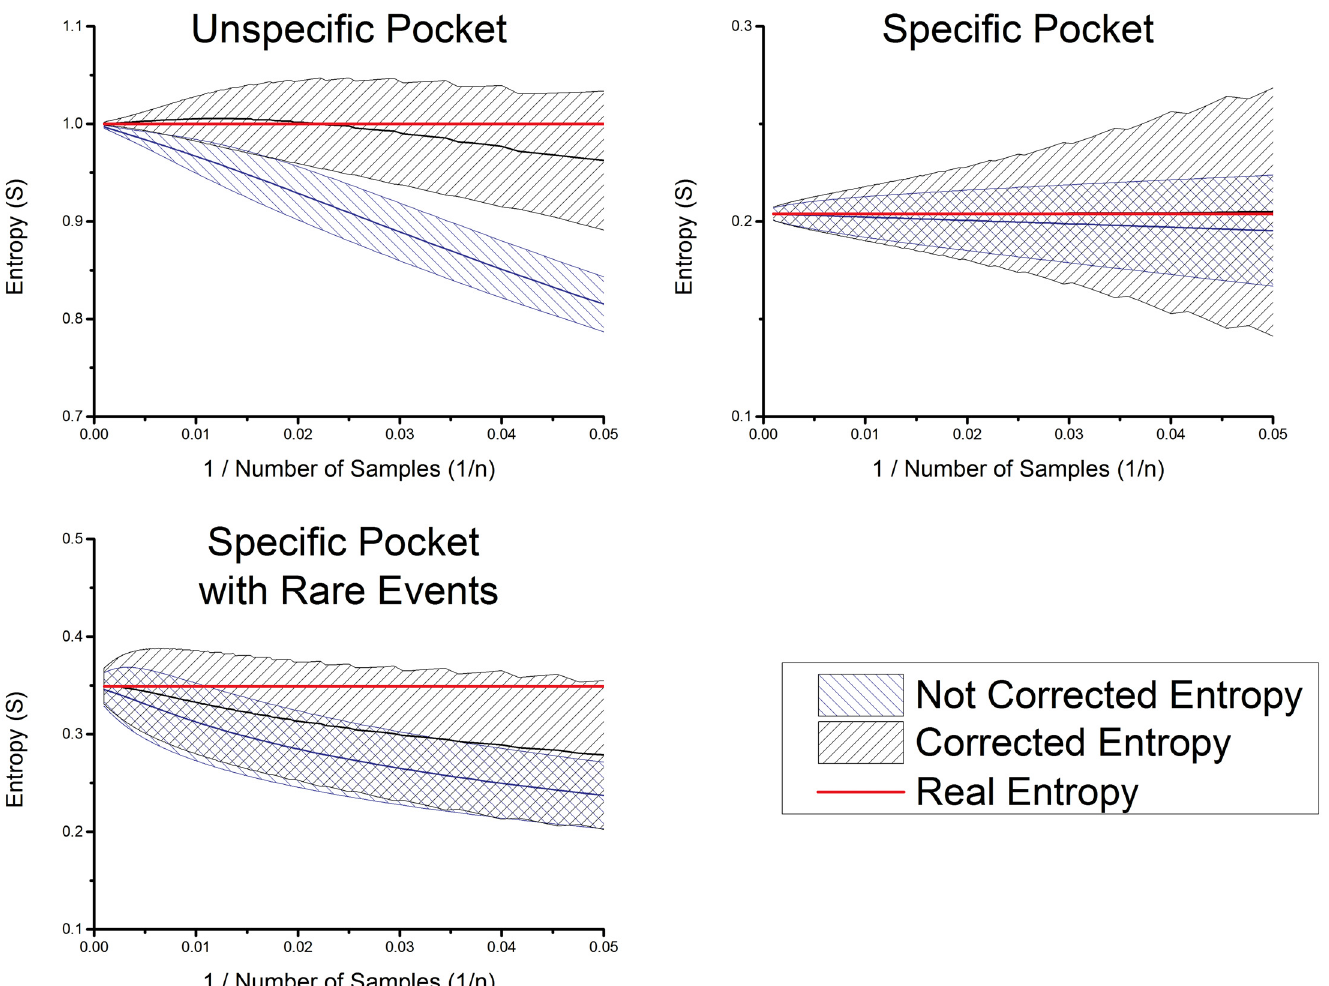
Fig 3. Trend of the measured and estimated entropy with the reciprocal number of known substrates. The cases of a totally unspecific pocket (upper left), an unspecific pocket (upper right) and an unspecific pocket with rare events (lower left) are shown. The filled areas correspond to the possible measured values including the standard